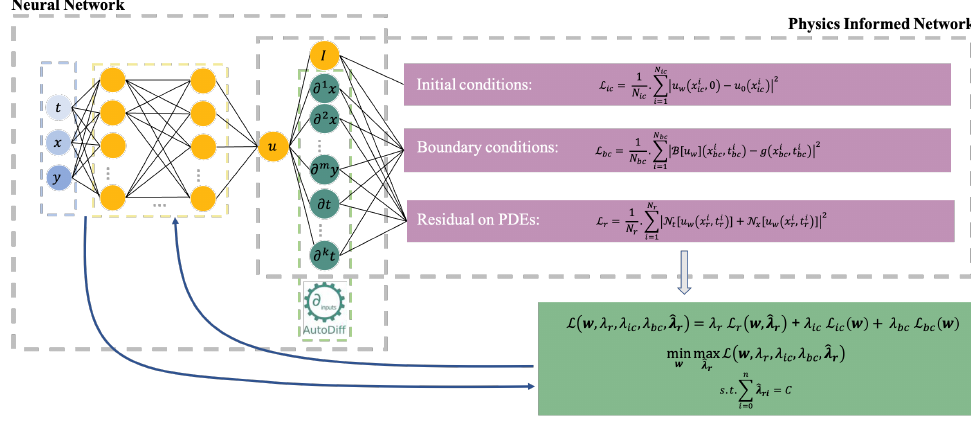
Figure 2. A framework of constrained self-adaptive physics-informed neural networks. A neural network output the solution u for PDE, then we computed the derivatives by auto differentiation and obtained the loss of initial conditions, boundary conditions and governing equation. The parameters of neural network and constrained self-adaptive weights for residual points were updated at the same time by means of the gradient